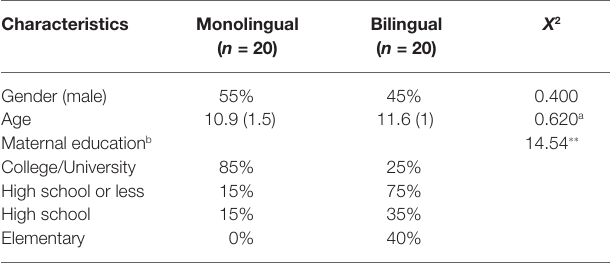
TABLE 1 | Participants’ characteristics. TABLE 2 | Bilingual participants’